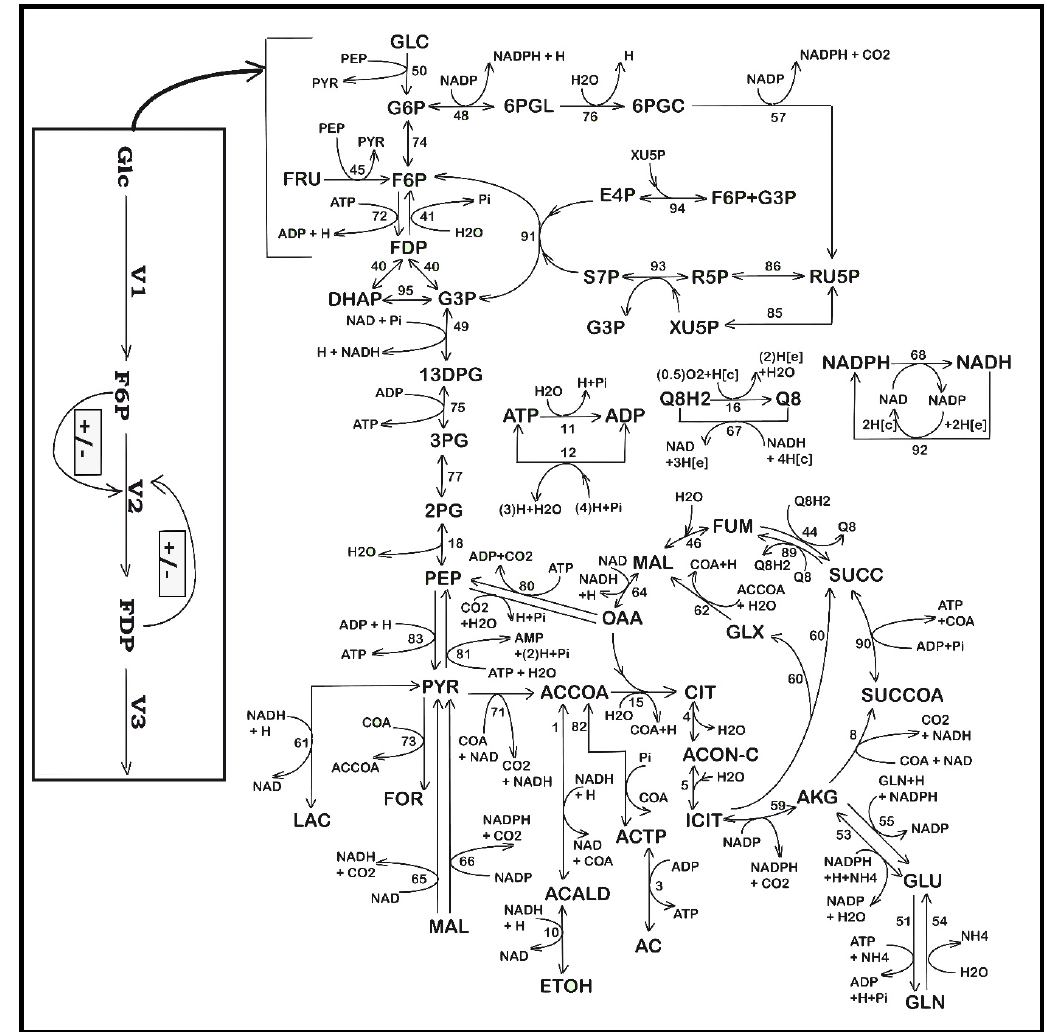
Figure 1. Simplified representation of the CCM pathway in E. coli of Edwards and Palsson [51] (i.e., the wild cell, including the PTS-system). Fluxes characterizing the membrane transport [ Metabolite (e) ↔ Metabolite (c)] and the exchange with environment are omitted from the plot (see [38] for details and explanations regarding the numbered reactions). Notations: [e] = environment; [c] = cytosol. Adapted from Maria et al. [38] with the courtesy of CABEQ Jl. The considered 72 metabolites, the stoichiometry of the 95 numbered reactions, and the net fluxes for specified conditions are given by Maria et al. [38]. The left rectangle indicates the chemical node inducing glycolytic oscillations [33,36]. Notations [+] and [ − ] denote the feedback positive and negative regulatory loops, respectively. GLC = glucose”. See the abbreviation list for species names; V1–V6 = lumped reaction rates discussed in the Section 3.1.3.